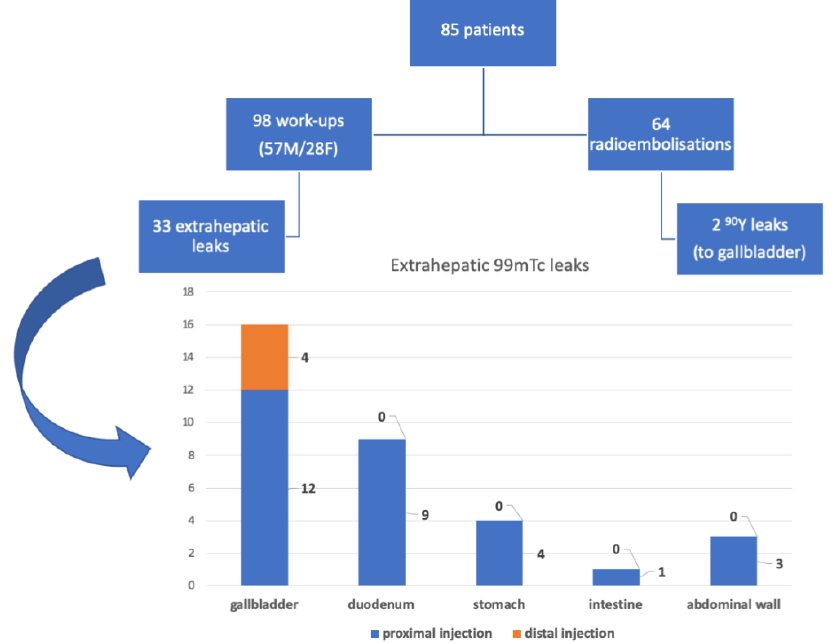
Figure 4. Flowchart presenting the sites of extrahepatic leaks in view of the site of injection.